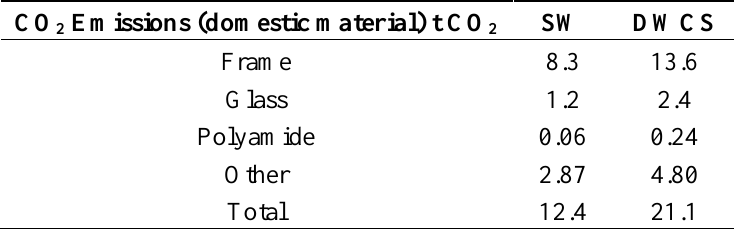
Table 13. Total embodied CO 2 emissions.